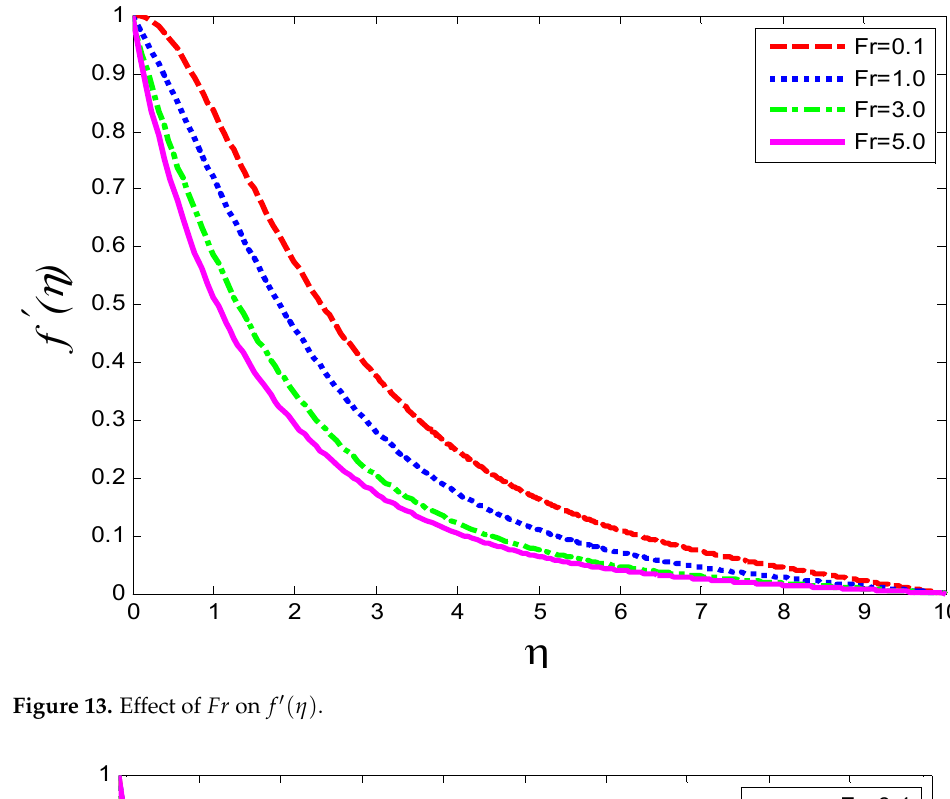
Figure 13. Effect of Fr on f (cid:48) ( η ) .